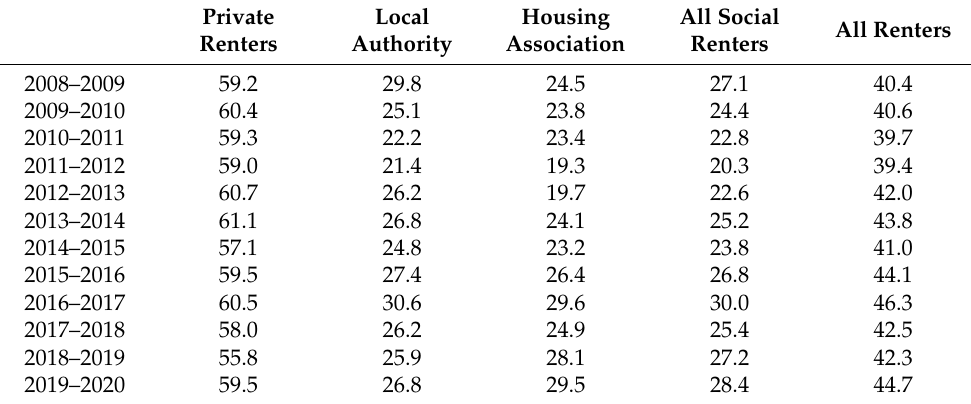
Table A15. Number and proportion of renters who expect to buy, 2008–2009 to 2019–2020 (percentages).